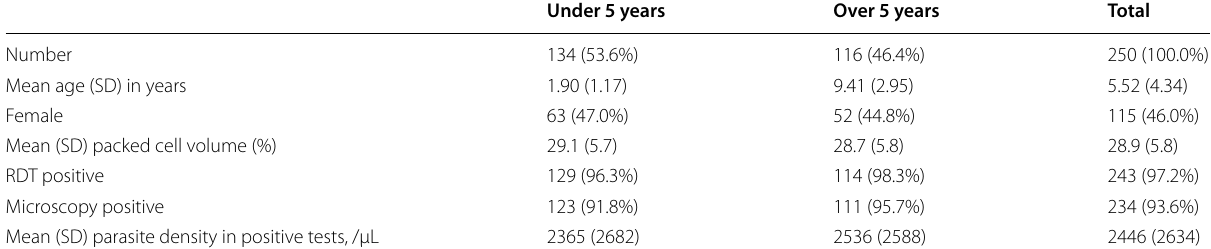
Table 1 Baseline characteristics of febrile children attending a primary health center in Owo, Nigeria, and malaria test results by mRDT